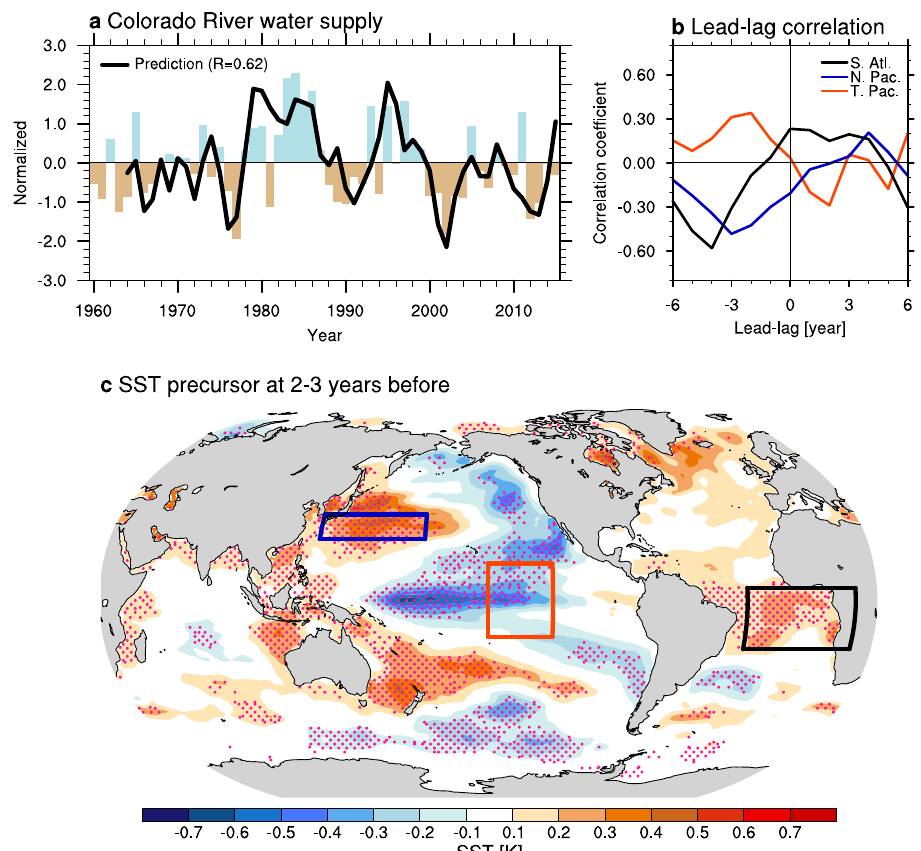
Fig. 5 SST precursors of Colorado River water supply shortages. a Timeseries of the normalized Colorado River water supply, showing observed (bar) and predicted based on the multiple regression of three SST precursors (black line; see “ Methods ” ). b Lead-lag correlations of the observed Colorado River water supply with the three SST precursors (see “ Methods ” ) averaged over the tropical Paci fi c (red), the North Paci fi c (blue), and the southern tropical Atlantic (black). Positive (negative) lead times indicate that the Colorado River water supply leads (lags) SST anomalies. c Composite map of observed SST anomalies at 2 – 3 years before the seven shortage years (i.e., 1963, 1976, 2000, 2001, 2002, 2012, and 2013; see Supplementary Fig. 2). Red, blue, and black boxes correspond to the area averaged regions in the tropical Paci fi c, North Paci fi c, and the southern tropical Atlantic, respectively. Pinks indicate the statistical signi fi cance at the 90% levels with two-sided Student ’ s t -tests for SST anomalies. SST anomalies are linearly detrended at each grid point from 1960 to